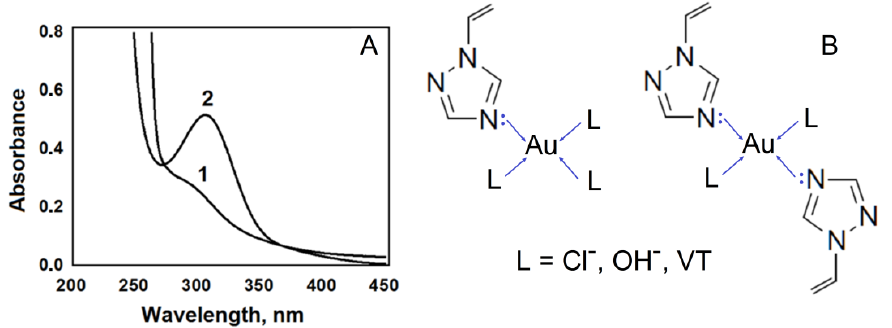
Figure 1. The UV-Vis spectra of VT–Au(III) (the ratio (VT)/(Au(III)) is 80/1) (1) and HAuCl 4 (2) aqueous solutions at pH 2.9 ( A ) and the proposed structures of the VT–Au(III) complexes ( B ).